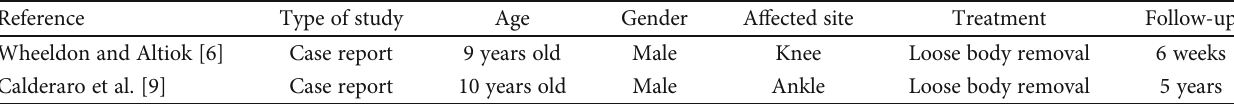
Table 1: Key fi ndings of published work of multiple loose body of DEH.